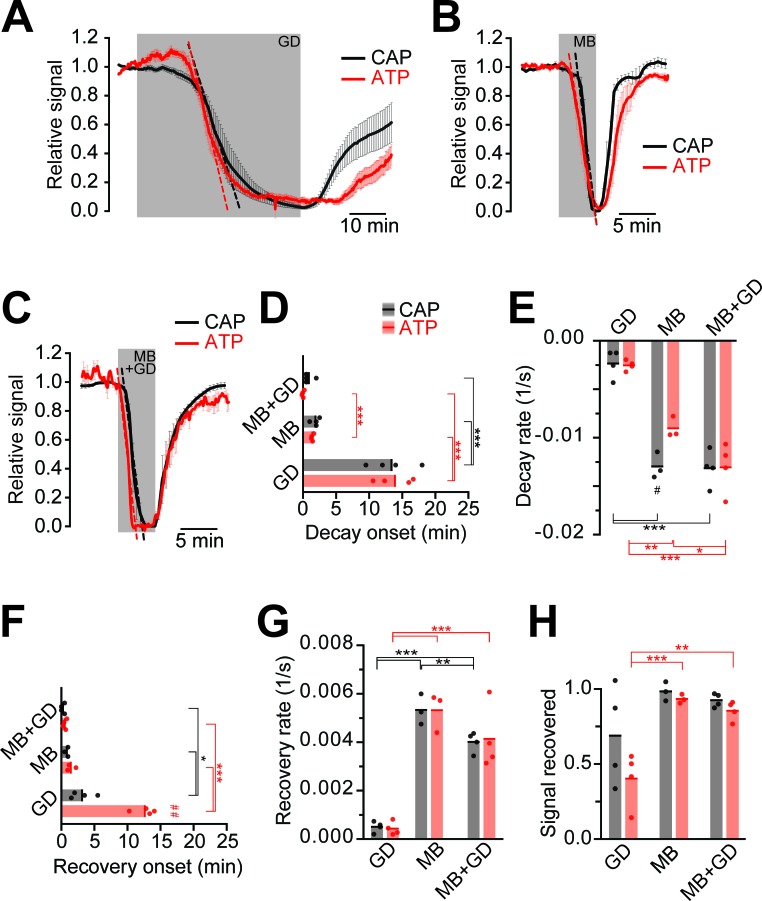
Impairment of axonal ATP and CAP by glucose deprivation and/or inhibition of mitochondrial respiration.(A) Removal of glucose from the aCSF (glucose deprivation, GD, 45 min) induces similar ATP (red) and CAP (black) decays starting at around 13 min after onset of the treatment. Red and black dashed, straight lines represent the maximum velocity of ATP and CAP decay (also applies to panels B and C). When 10 mM glucose is restored, CAP recovery precedes ATP restoration (n = 4 nerves). (B) Blockade of mitochondrial respiration by azide (MB, 5 min) produces a fast decay in ATP (red) and CAP (black) starting at 1.8 min after beginning of treatment. When azide is removed, CAP and ATP are promptly restored, with CAP recovery preceding the ATP increase (n = 4 nerves). (C) Simultaneous removal of glucose and blockade of mitochondrial respiration with azide (MB+GD, 5 min) produces a fast decay in ATP (red) preceding CAP decay (black), starting already 0.5 min after onset of treatment. Following azide removal and replenishment of glucose, CAP and ATP are restored (n = 4 nerves). (D) Time of onset of the ATP or CAP decay. The slowest decay induction was observed during glucose deprivation. (E) Velocity of signal decay for ATP and CAP during each of the three treatments: glucose deprivation (GD), mitochondrial blockage (MB) and the combination of both (MB+GD). (F) Time of onset of ATP or CAP recovery after reperfusion with control aCSF containing 10 mM glucose. (G) Rate of recovery of both ATP and CAP during reperfusion of the nerves with aCSF containing 10 mM glucose after the treatments indicated. (H) Comparison of ATP and CAP area overall recovery after individual treatments. Data in D–H is presented as stripe plots, with dots representing individual data points, bars and lines showing the mean. Hash signs indicate statistically significant differences between ATP and CAP under the same condition (#p<0.05, ##p<0.01, paired t-test); asterisks on red (ATP) and black (CAP) lines indicate statistically significant differences between different conditions (*p<0.05, **p<0.01, ***p<0.001; one-way ANOVA with Newman-Keuls post-hoc test).DOI:
http://dx.doi.org/10.7554/eLife.24241.00610.7554/eLife.24241.007Figure 3—source data 1.Table containing data for Figure 3.This xlsx-data file contains the data shown in Figure 3D–H and Figure 3—Figure supplement 2.